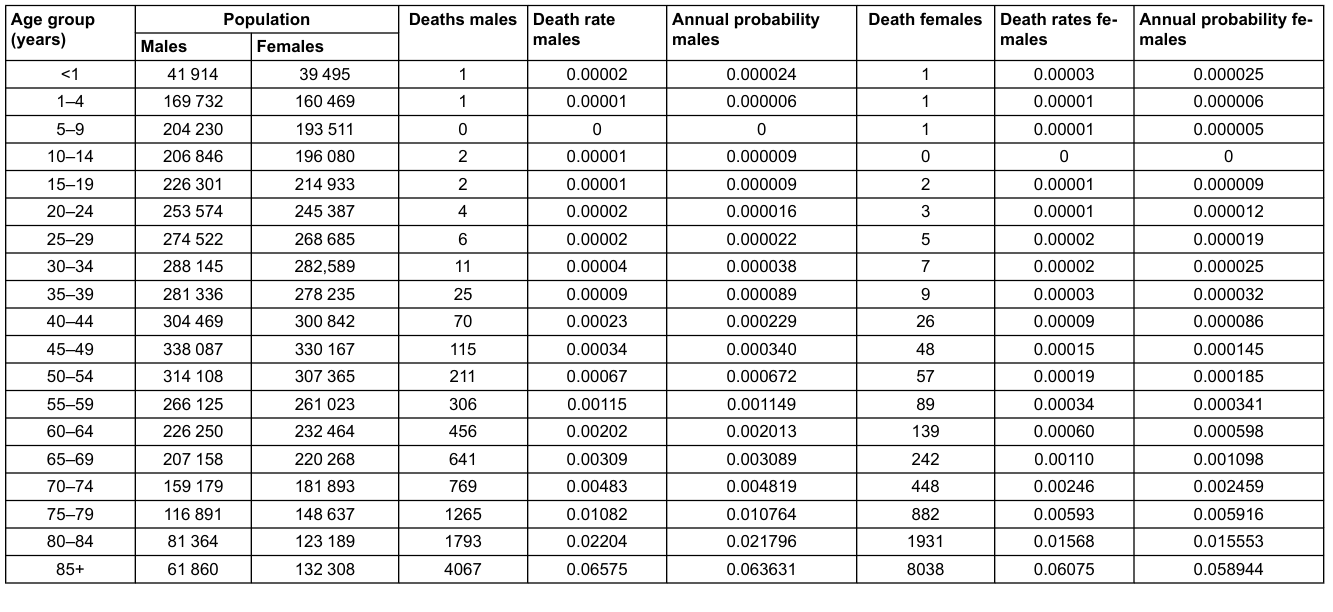
Table S5: Cardiovascular mortality of the Swiss population in 2012 .